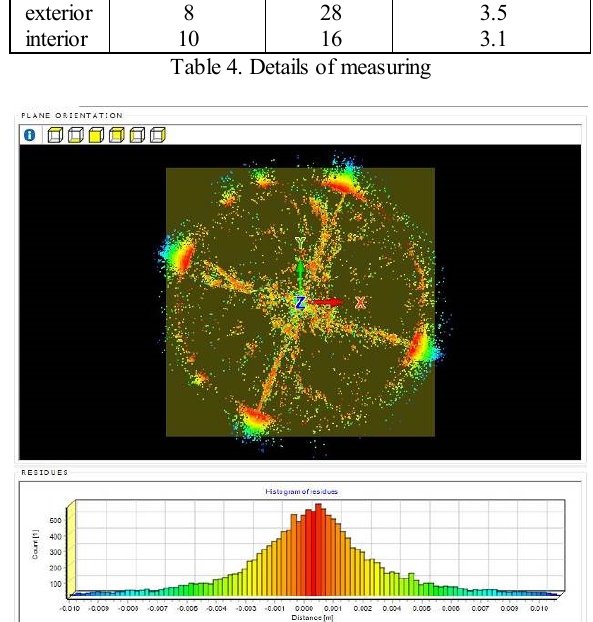
Figure 5. Histogram of